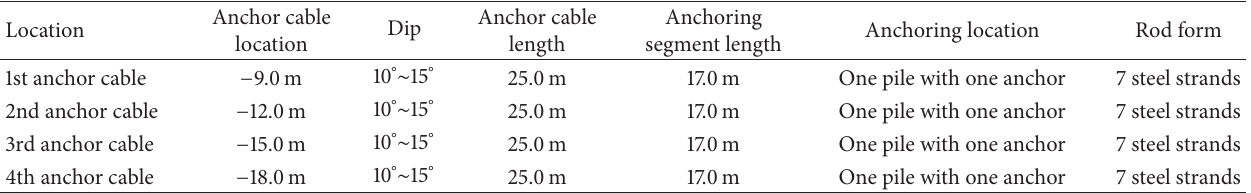
Table 4: Design parameters of anchor cables of eastern, southern, and western support pile